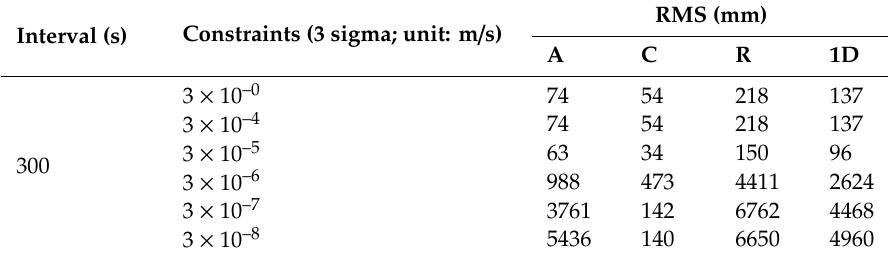
Table 5. Di ff erences of orbits estimated and published by CODE (16:00:00–18:00:00). Interval